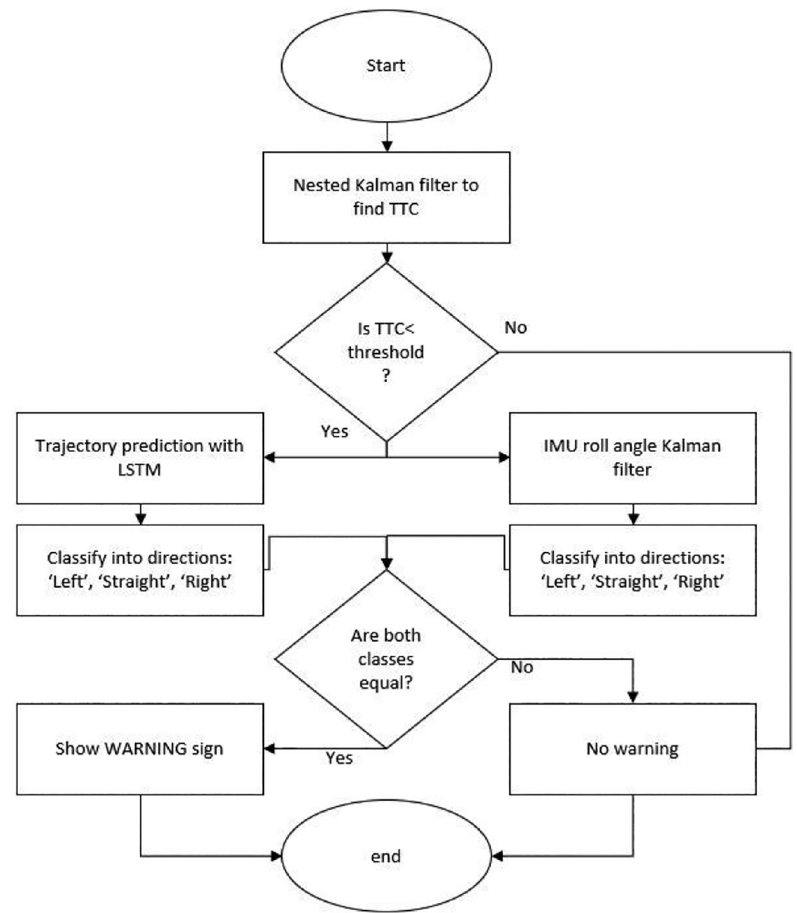
Figure 9 Algorithms integrated fl